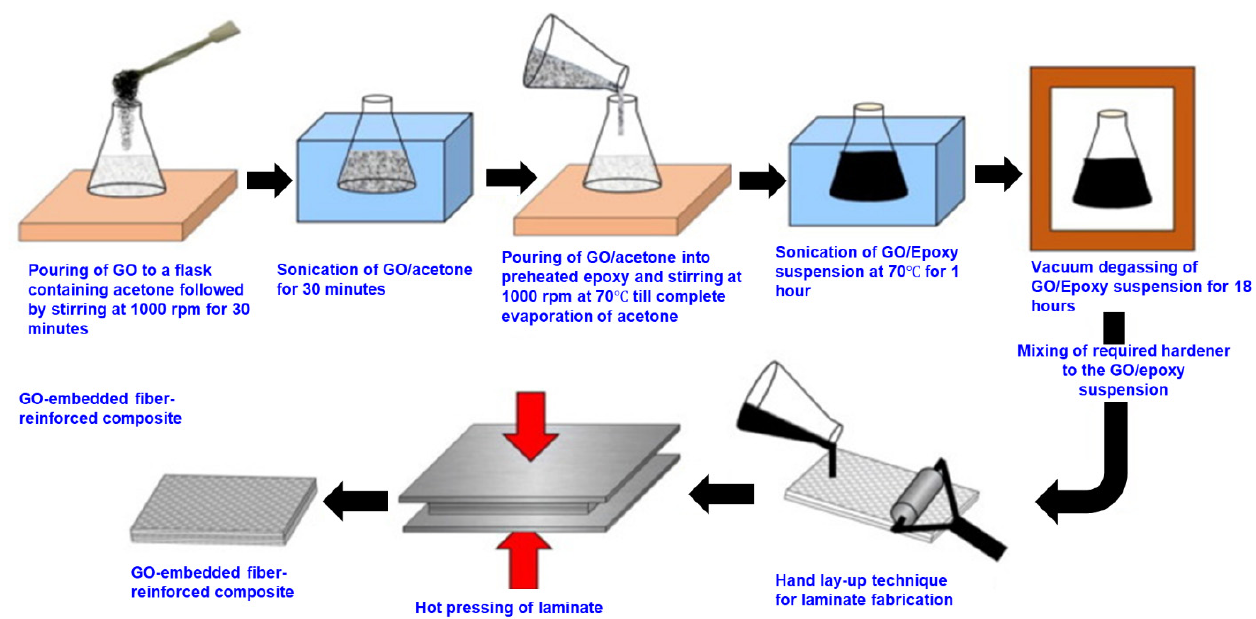
Figure 8. Fabrication steps of the gFPCs via matrix modification method; Reprinted with permission from [156].